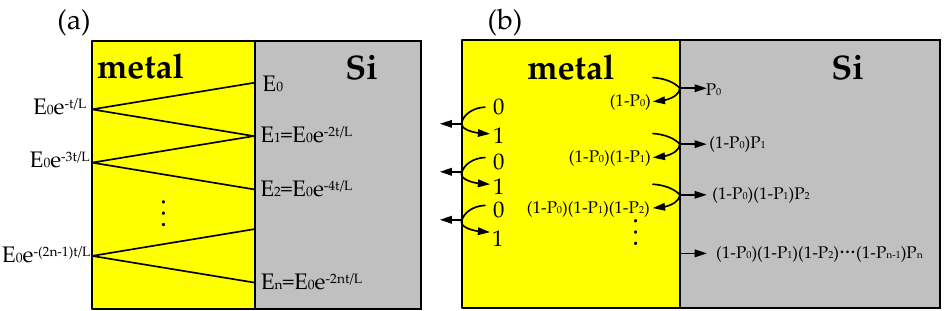
Figure 1. The collision model of the thin film single barrier photodetectors proposed by Scales [24]: ( a ) excess energy of a (non-emitted) hot carrier at metal / Si interface; ( b ) emission probability of a hot carrier as the number of reflections increases .